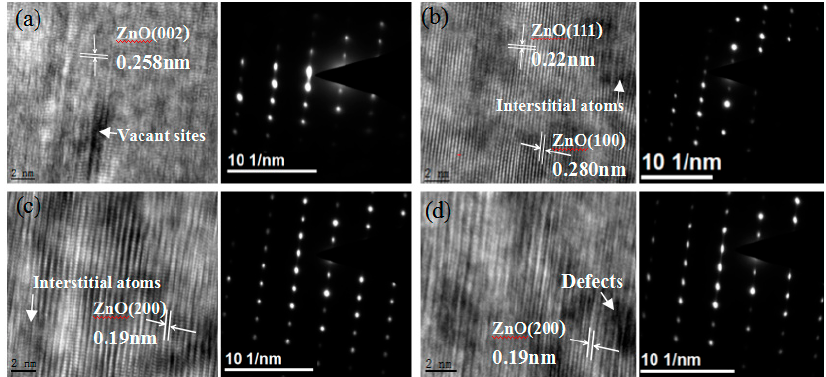
Figure 3. TEM images and corresponding diffraction patterns of 56 Fe 21+ ion irradiated ZnO at different depths (( a ) is 2 μ m, ( b ) is 10 μ m, ( c ) is 25 μ m, ( d ) is 32 μ m) along the incident direction of 56 Fe 21+ ions. Irradiation does of heavy ions were 1 × 10 14 ions/cm 2 .